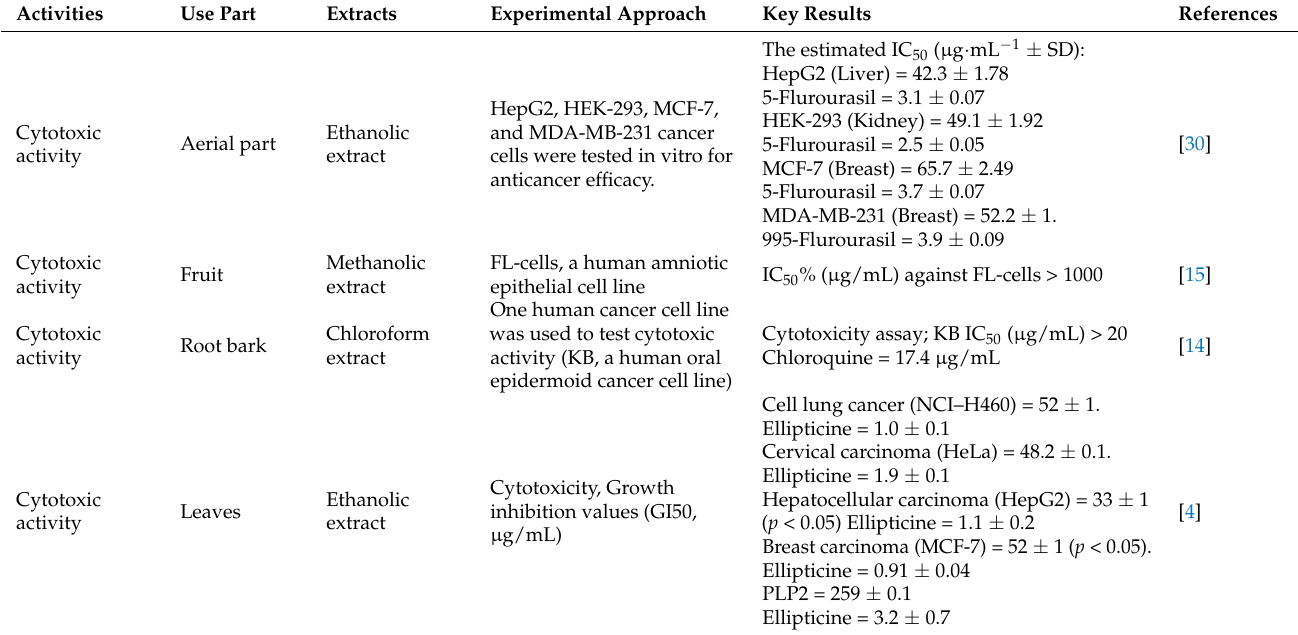
Table 6. Antiproliferative activity of V. tortilis